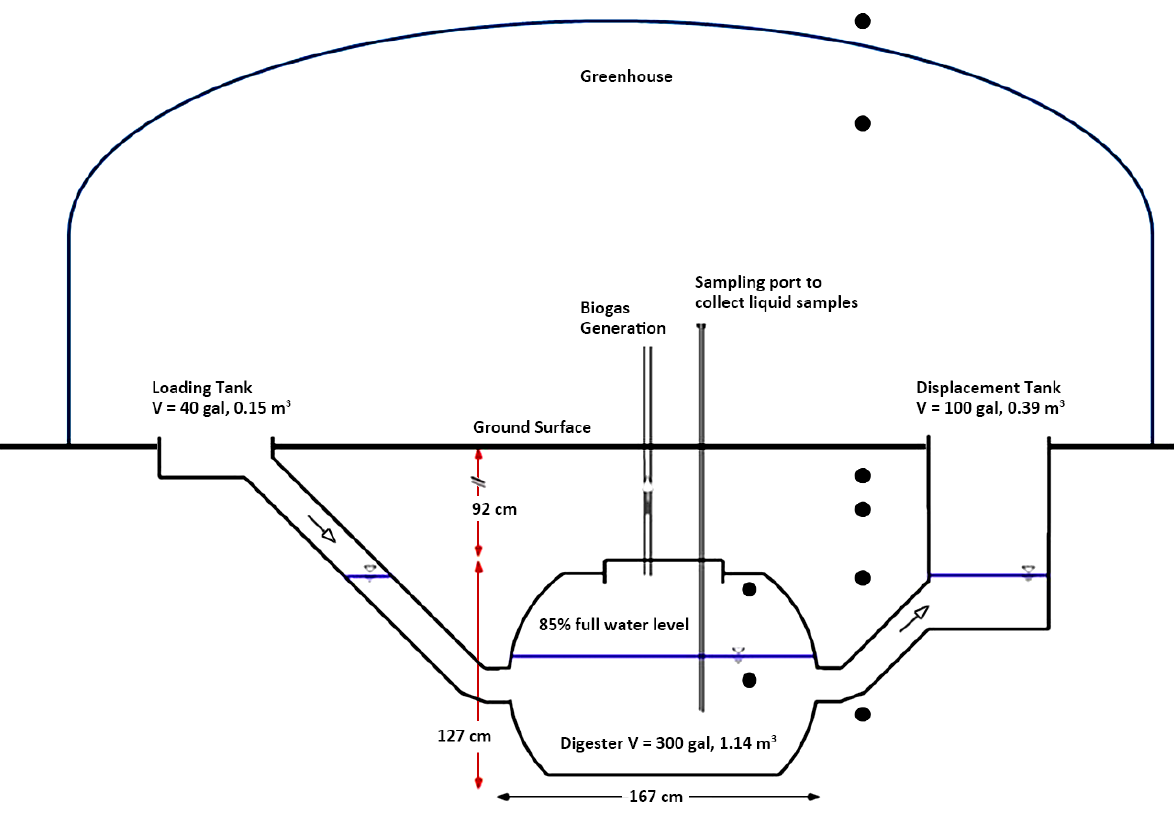
Figure 4. Modified fixed-dome digester used for this study. Black dots indicate the locations where thermocouples recorded